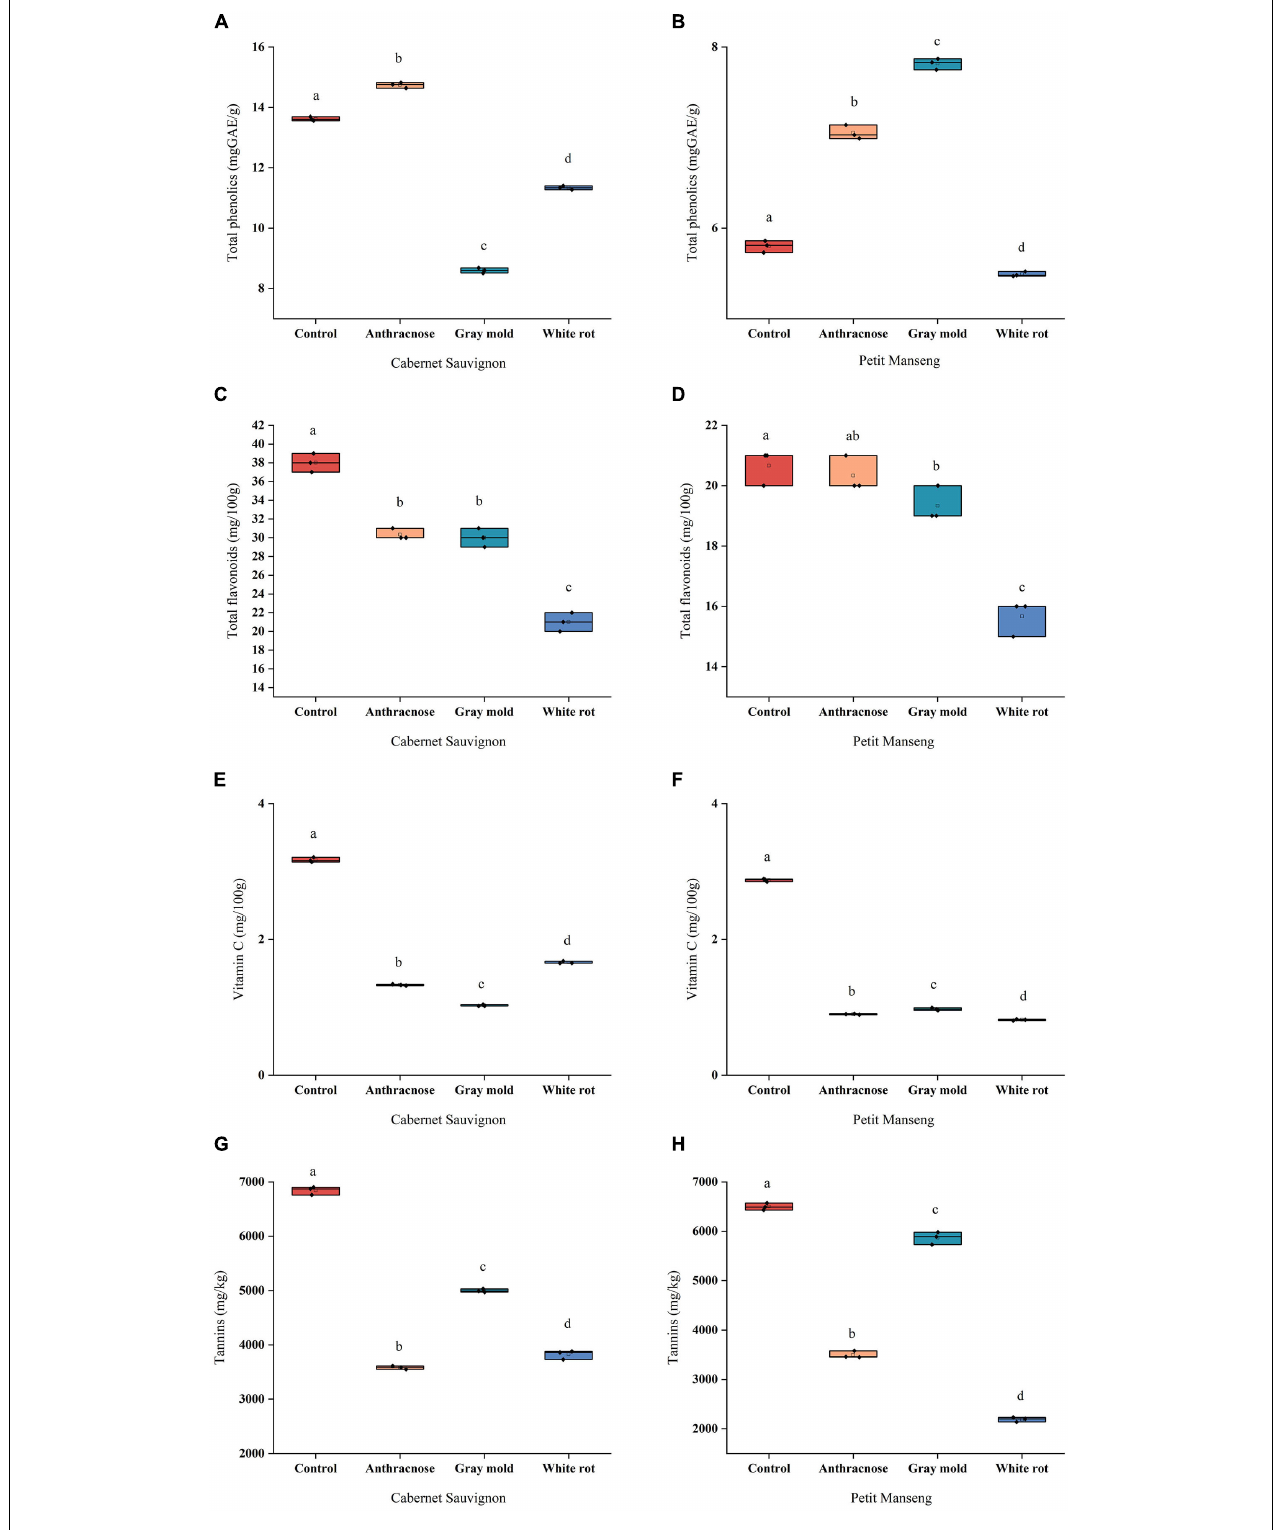
FIGURE 2 | The scattered boxplots show the content of the phenolic compounds and vitamin C in all samples of Cabernet Sauvignon and Petit Manseng grapes: (A, B) Total phenolics (TP); (C, D) Total flavonoids (TF); (E, F) Vitamin C; (G, H) Tannins. Different letters (lower case) on the top of the bars represent significant differences among the investigated grape samples. Scattered boxplots show individual data points, median, average value, 25th, and 75th percentile.